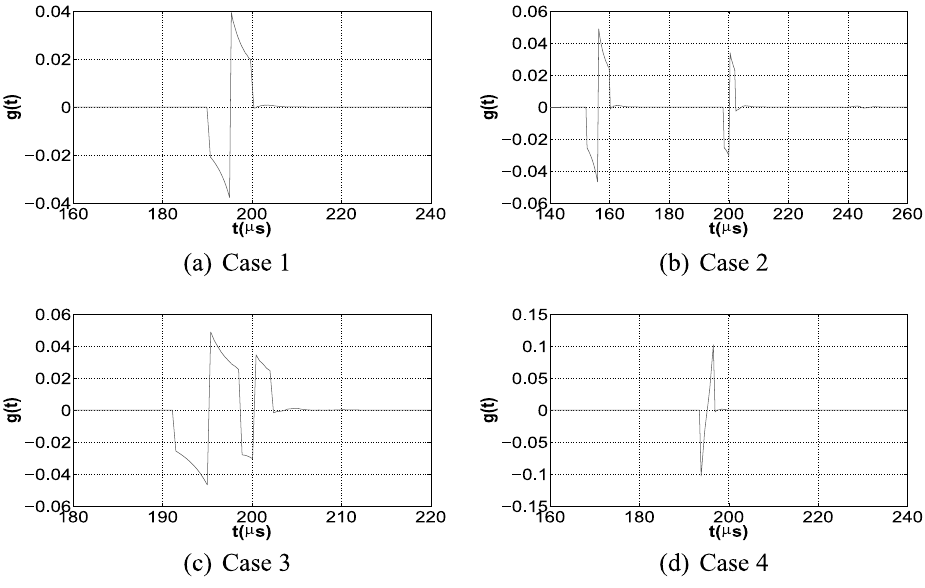
Fig. 2. Impulse responses from the pulse-echo tests for the four damage